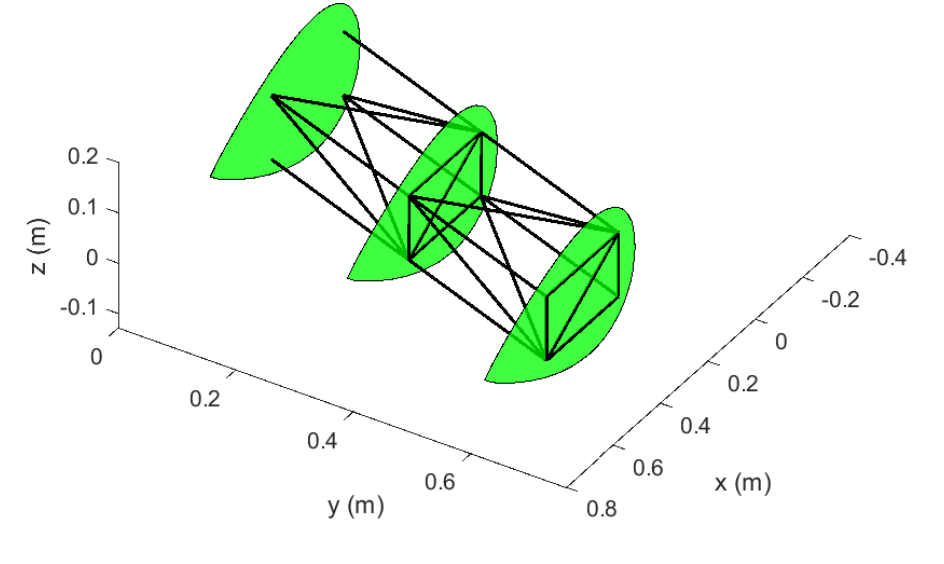
Figure 8. Undeformed wing with hinged ends; twist = 0 ◦ , sweep = 30 ◦ , dihedral = 0 ◦ , expansion = 20% (simulation 25).